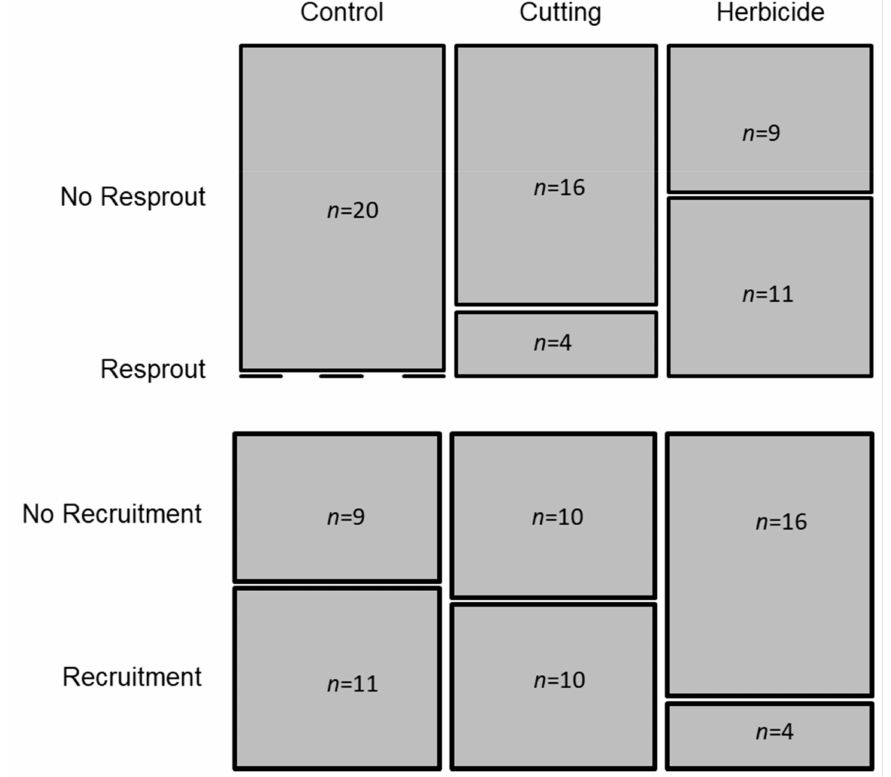
Figure 4. Frequency of plots with presence and absence of resprouting ( upper graph ) and recruitment ( lower graph ), over the experiment ( n = 60), distributed by